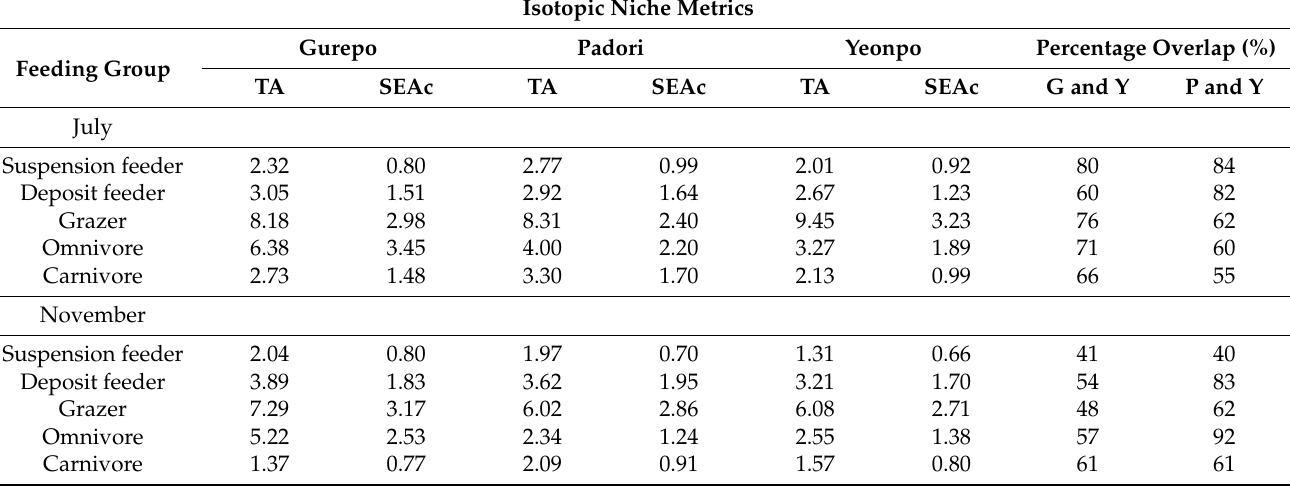
Table 4. Isotopic niche areas of each feeding group (suspension feeder, deposit feeder, grazer, omnivore, carnivore) estimated as the total area (TA) and standard ellipse area (SEAc) and isotopic niche overlaps (percentage) between the heavily oil-impacted (Gurepo, G and Padori, P) and non- impacted reference (Yeonpo, Y) sites using the Stable Isotope Bayesian Ellipse in R (SIBER)